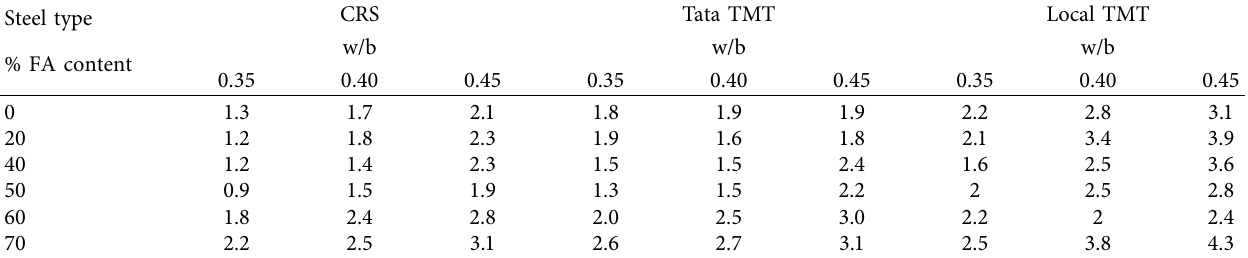
Table 4: Icorr ( μ A/cm 2 ) for carbonated CPSE for various types of steel and different fly-ash content with water-binder ratios. Steel type CRS Tata TMT Local